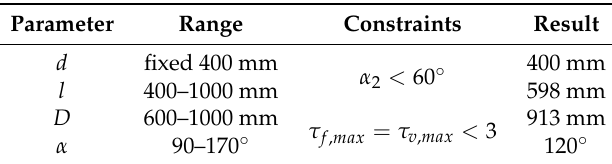
Table 1. Optimization parameters.